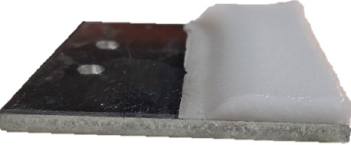
Figure 3. The ice was accreted in one half of the area of the 50 × 50 mm 2 samples using a mask to have an iced area of 12.5 cm 2 .